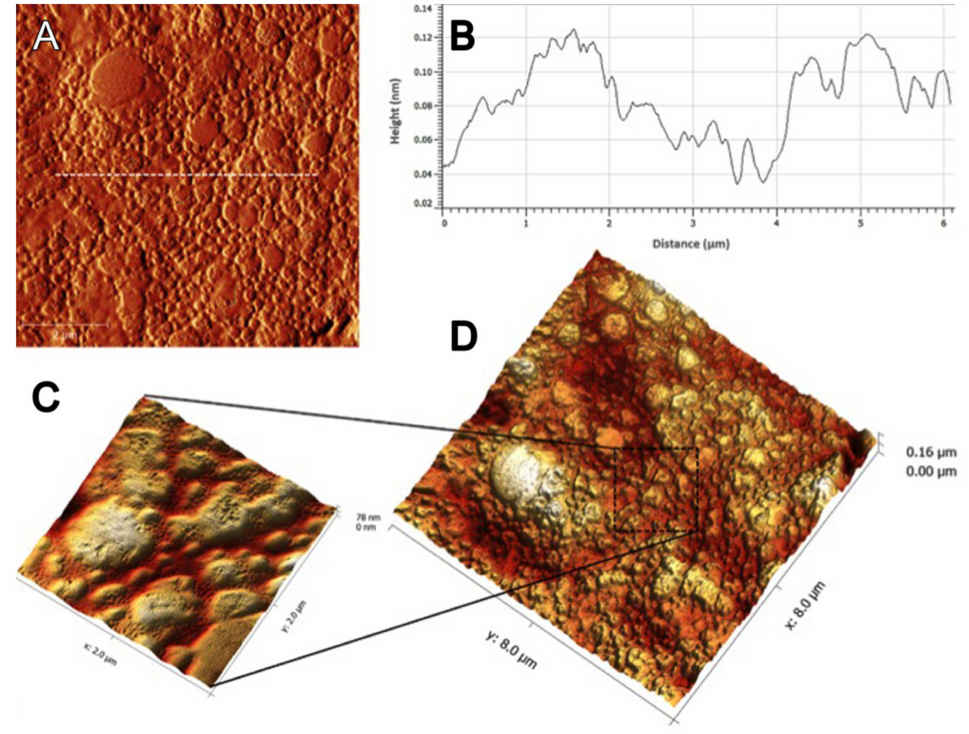
Figure 6. Atomic force microscopy images of the NFBX surface. ( A ) AFM height image; ( B ) Cross- section height profile (taken along the white line in the image ( A ) and ( C , D ) 3D AFM topographic images. Ra = 14.28 ± 3.28